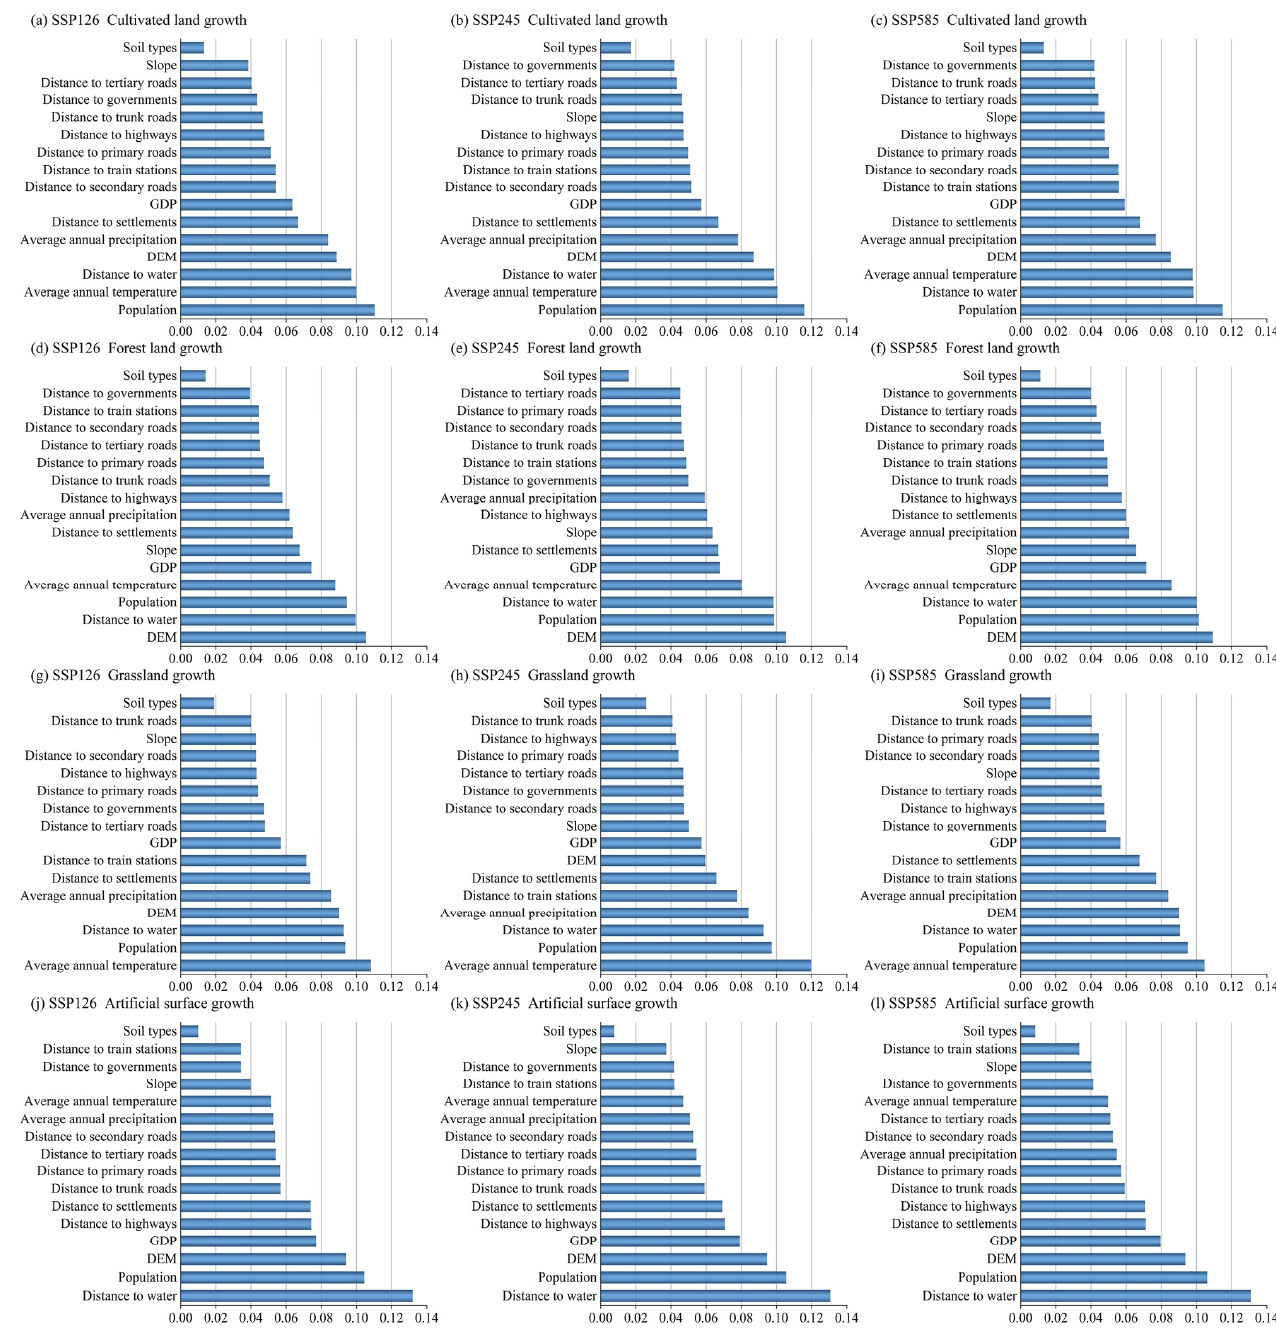
Figure 9. The importance of the contribution of each factor to the growth of four land use types.